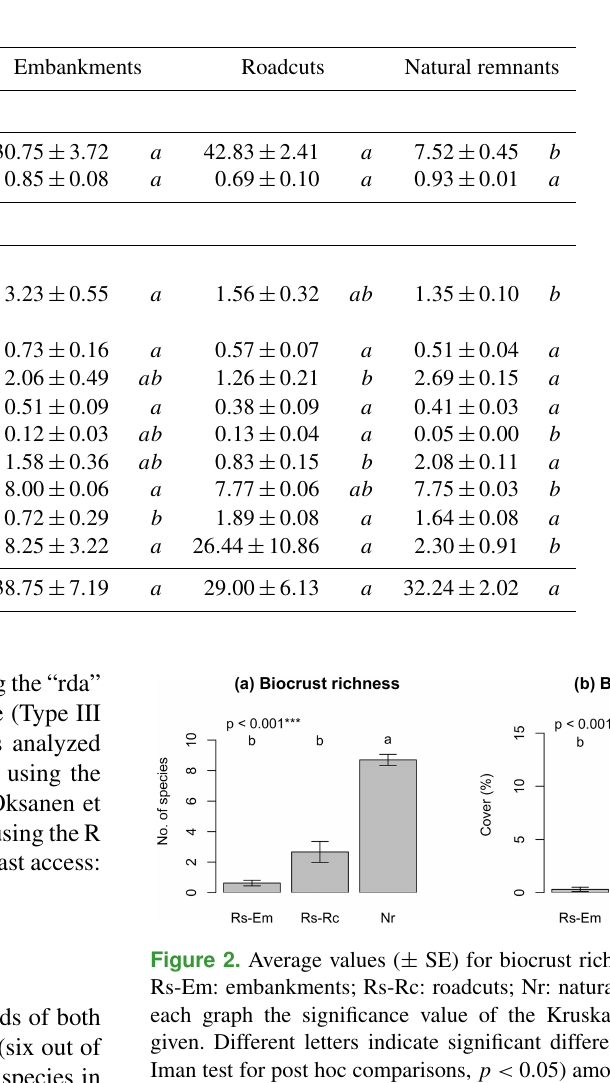
Table 3. Average values ( ± SE) for topography, soil properties and plant cover at each scenario. For each variable the significance value of the corresponding Kruskal–Wallis test is given. Different letters indicate significant differences (Conover–Iman test for post hoc comparisons, p < 0 . 05).